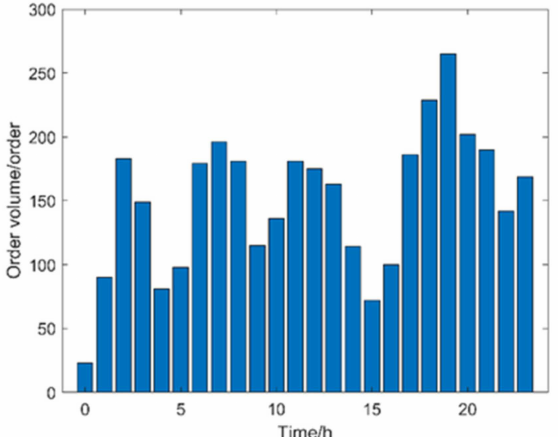
Figure 1. The order volume of electric taxis at each moment of the day.